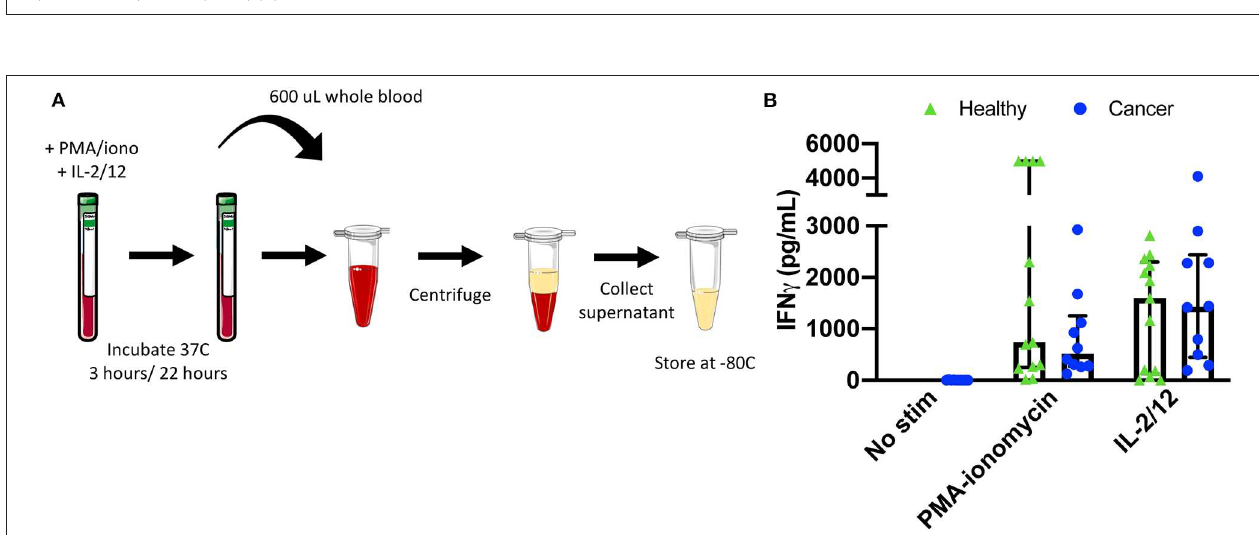
FIGURE 6 | Plasma collection methodology for secretory cytokine quantification by ELISA. After incubation in the absence of stimulation or with either PMA-ionomycin or IL-2/12 stimulation for 24h, 600 µ L of whole blood was collected and spun down prior to being collected and stored at − 80 ◦ C for subsequent use in a human IFN γ ELISA (A) . Extracellular IFN γ was quantified in response to stimuli in healthy donors ( n = 13) and cancer patients ( n = 10) (B) . Shown are the median values ± IQR.